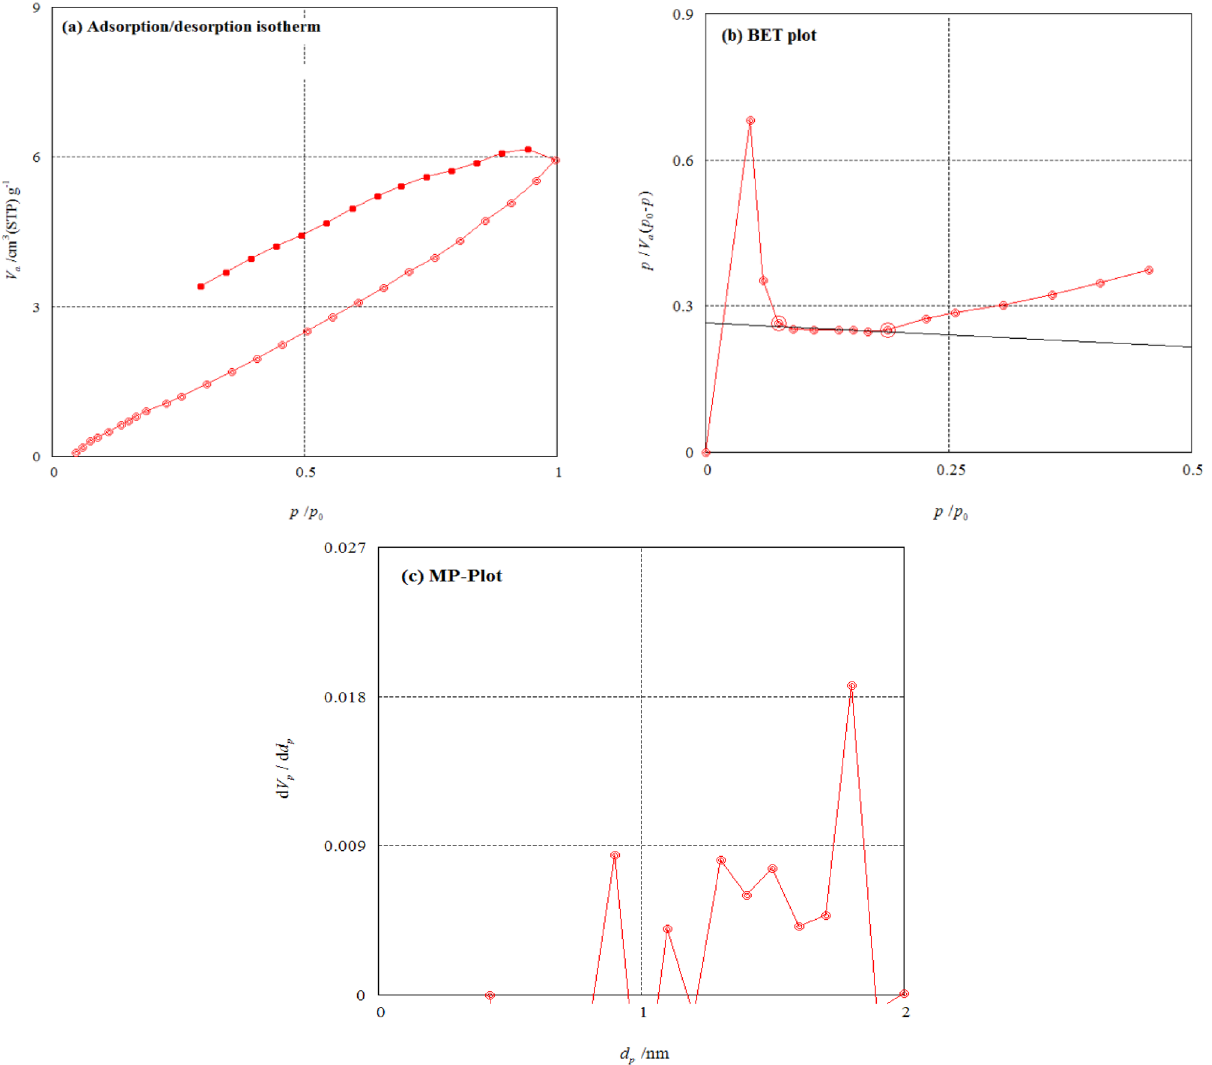
Figure 7. Surface area analysis ( a ) Adsorption/desorption isotherm, ( b ) BET analysis plot, ( c ) Micropore analysis (MP)